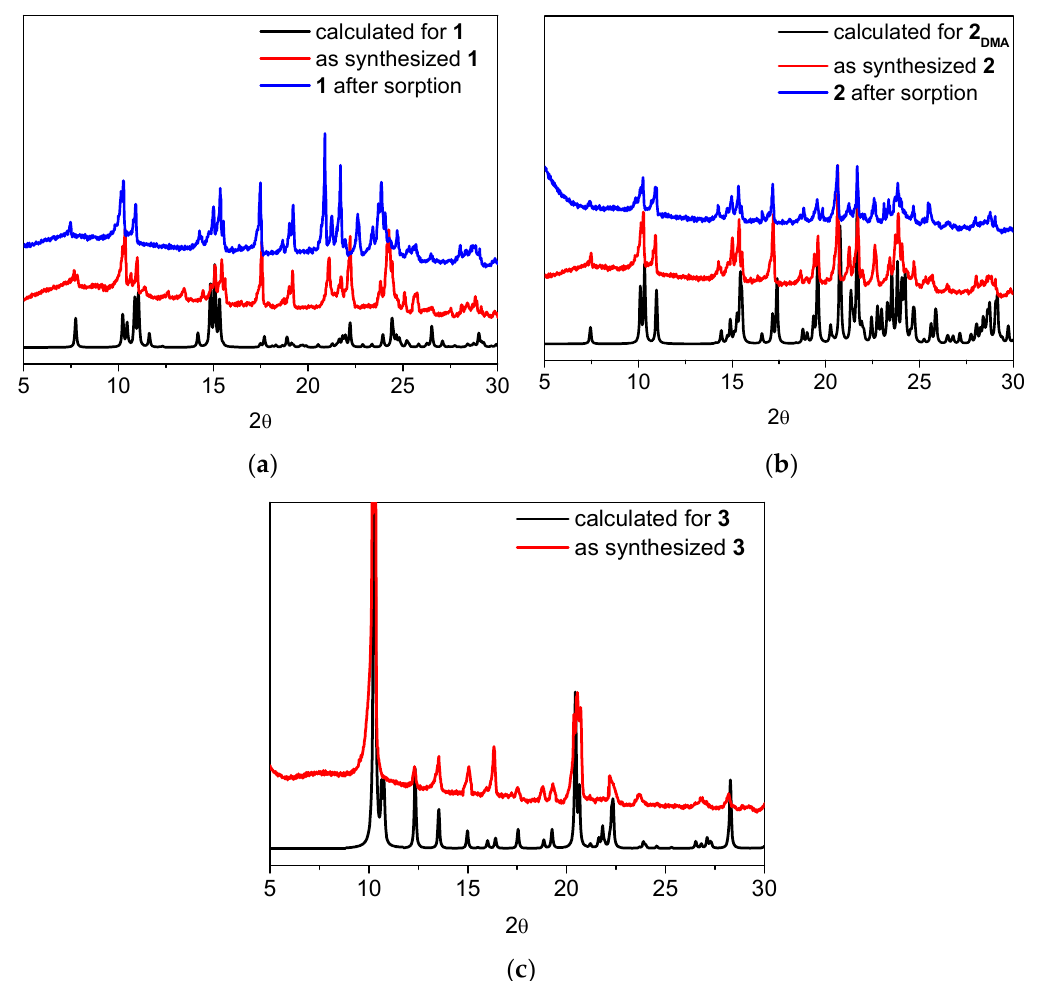
Figure 6. ( a ) PXRD patterns of as synthesized 1 and after sorption of N 2 and CO 2 in comparison with calculated one; ( b ) PXRD patterns of as synthesized 2 and after sorption of N 2 and CO 2 in comparison with calculated one; ( c ) PXRD patterns of as synthesized 3 in comparison with calculated one.